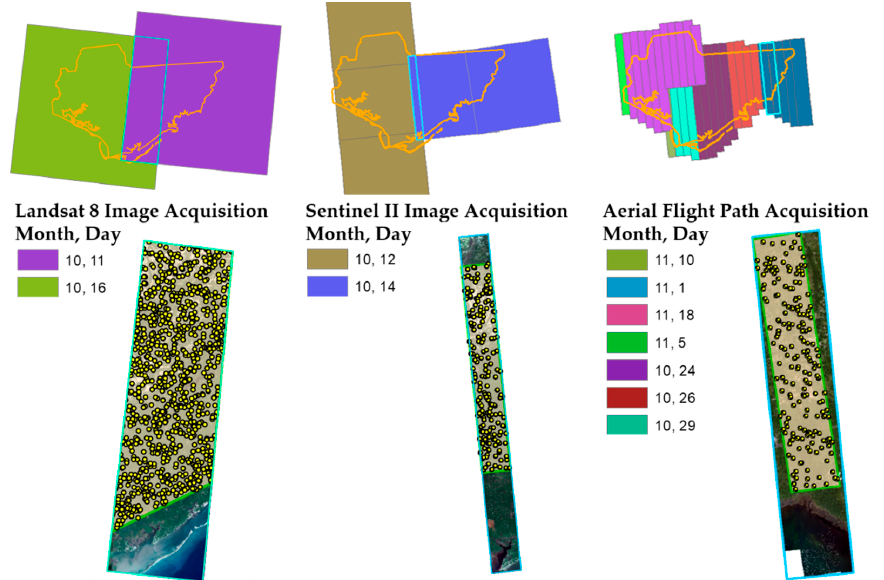
Figure 3. Example of spatial masks (semitransparent beige polygon with green border) and random locations (yellow points) used in the enhanced aggregate no-change regression procedure (EANR) for LDS Landsat 8, Sentinel 2, and aerial imagery. Light blue polygons highlight the overlapping area between images acquired at different dates while masked areas highlight a subset of that area composed primarily of forest vegetation.